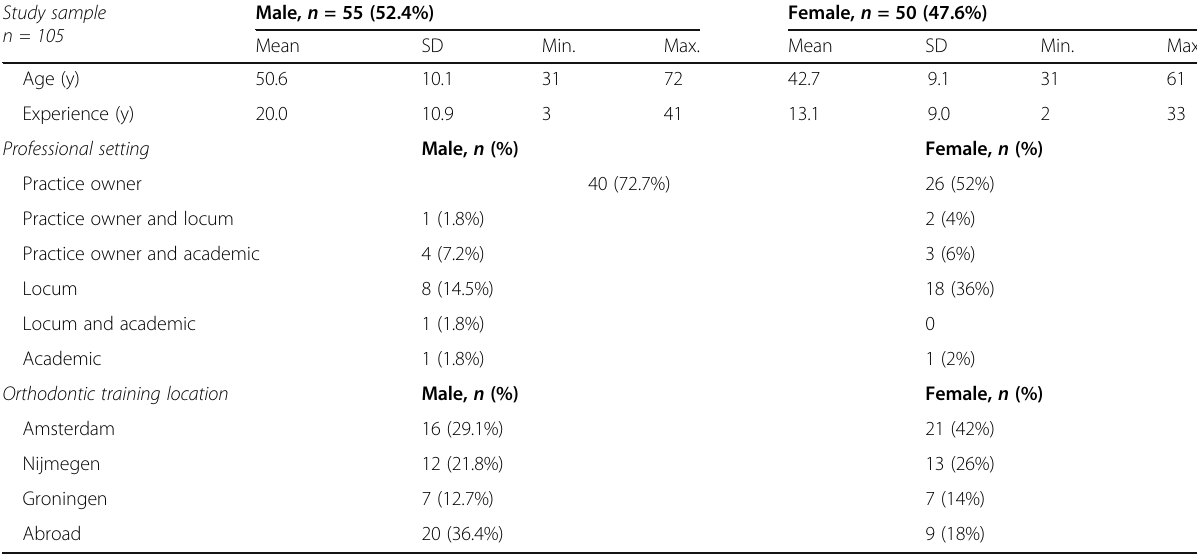
Table 1 Sample characteristics